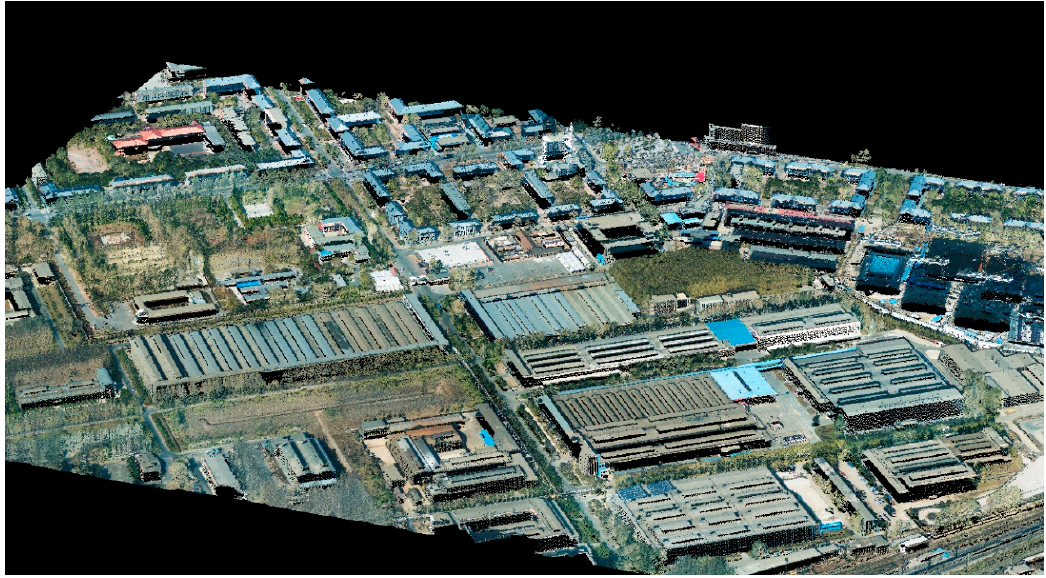
Table 1. Distances between check pair lines and their statistics. Figure 10. 3D visualization of a rural scene in Changchun using the colorized 3D LiDAR point.